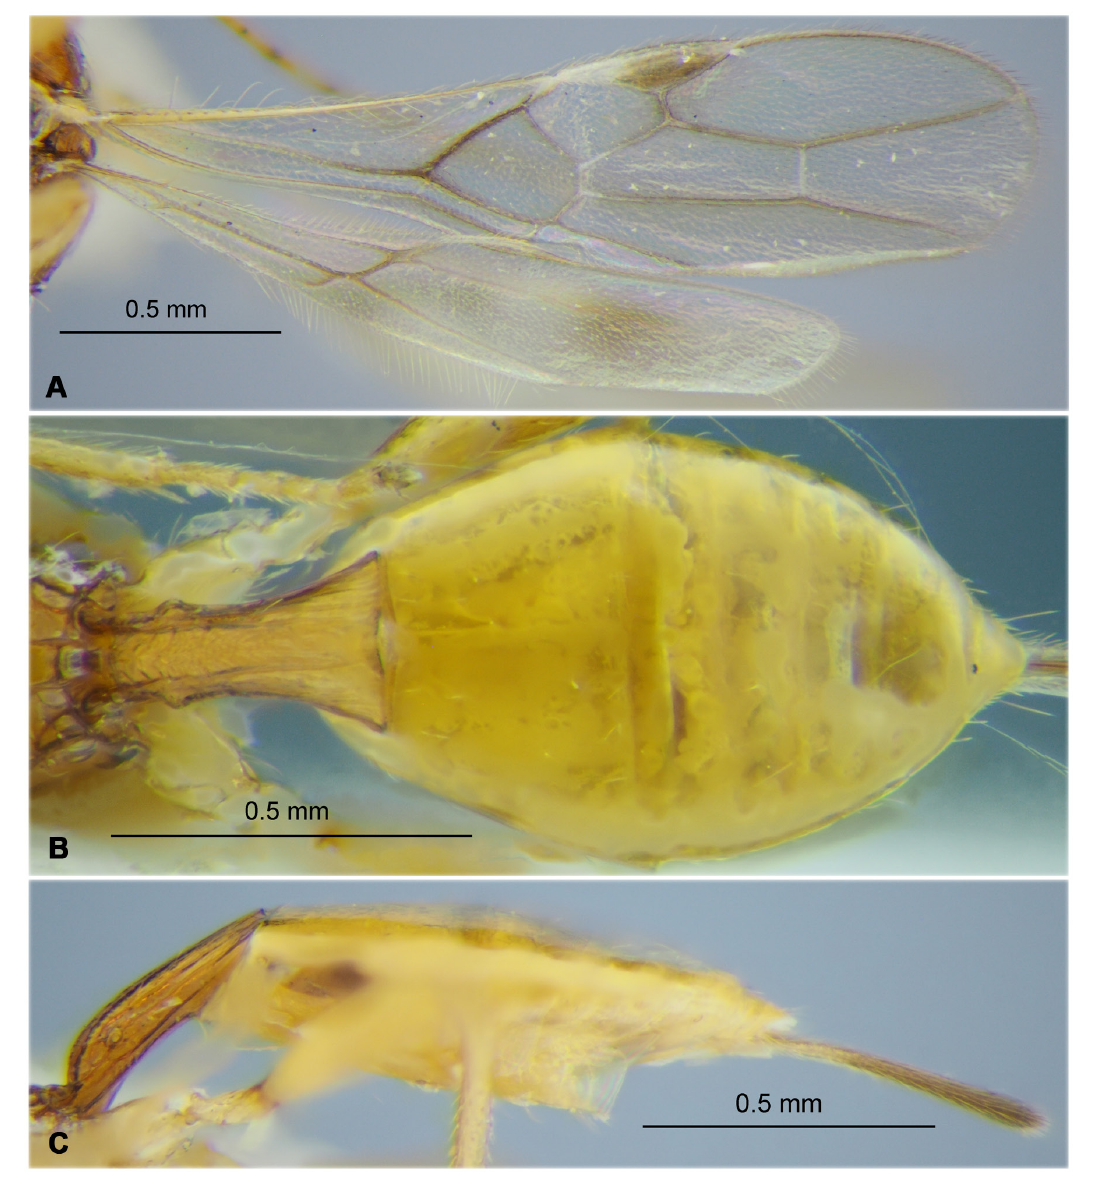
Fig. 19. Spathius austroarabicus Belokobylskij sp. nov., holotype, ♀ (RMNH). A . Wings. B . Metasoma, dorsal view. C . Metasoma and ovipositor, lateral